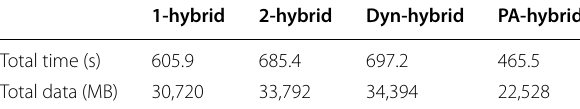
Table 5 Total migration time and transferred data